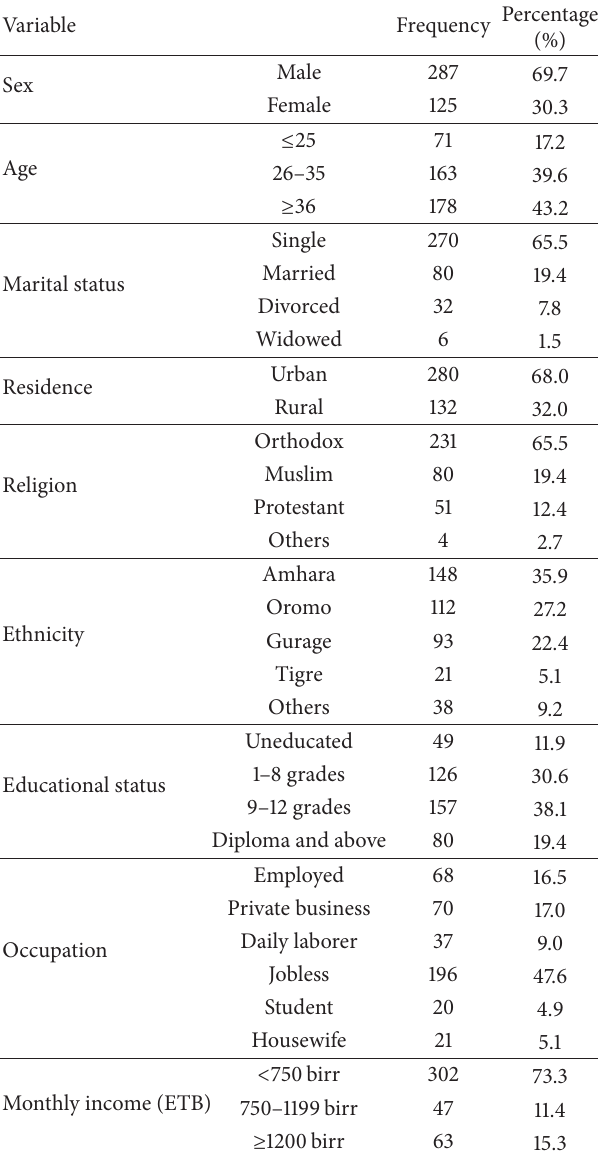
Table 2: Distribution of clinical and patient related factors among schizophrenia patients at AMSH, Addis Ababa, Ethiopia, June 2014 ( 𝑛 = 412 ).